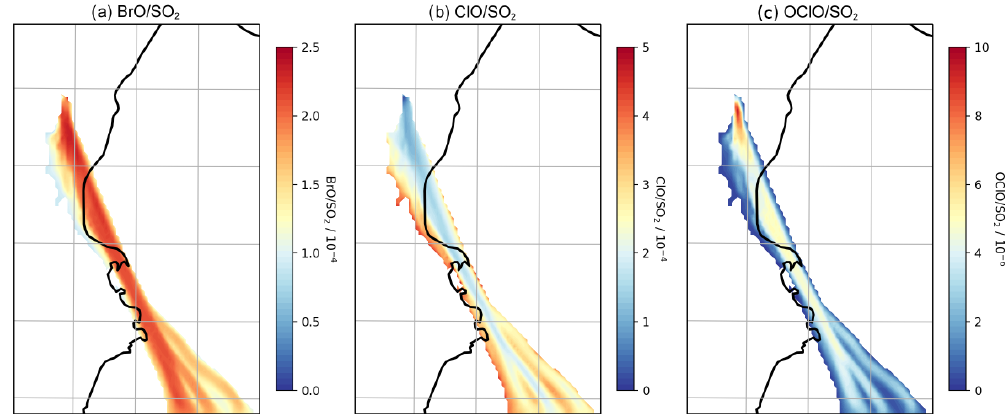
Figure 13. Model column ratios at 08:00UTC on 1 August 2012: (a) BrO / SO 2 , (b) ClO / SO 2 , (c) OClO / SO 2 . Only columns with a modelled SO 2 density greater than 2 × 10 16 are plotted.